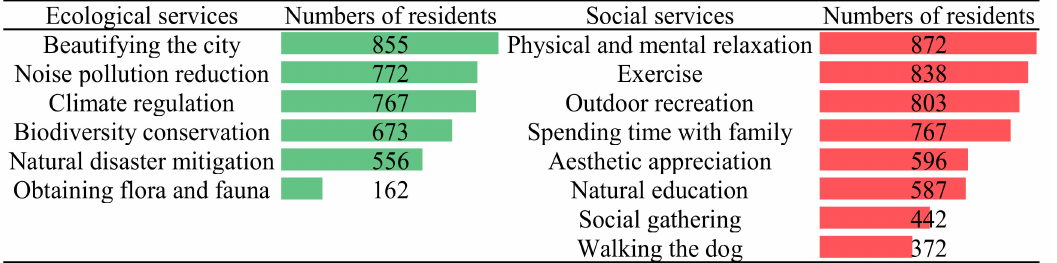
Figure 4. Numbers of residents willing to contribute to protecting services of urban green